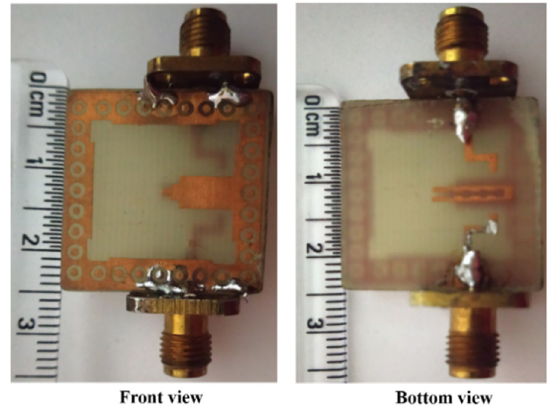
Figure 18. Prototype of circularly polarized MIMO antenna